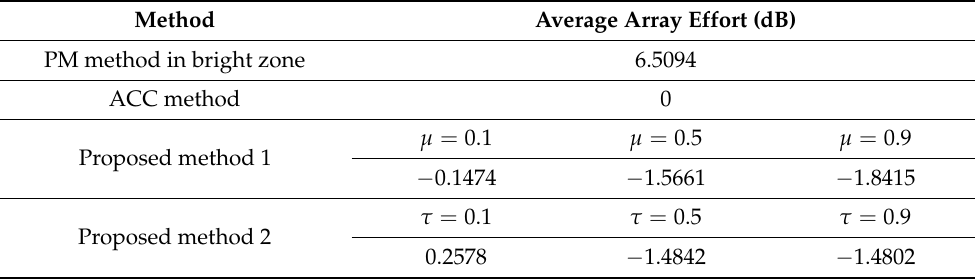
Table 14. Average array effort of different methods relative to frequency for three-dimensional experiment with sparse sampling